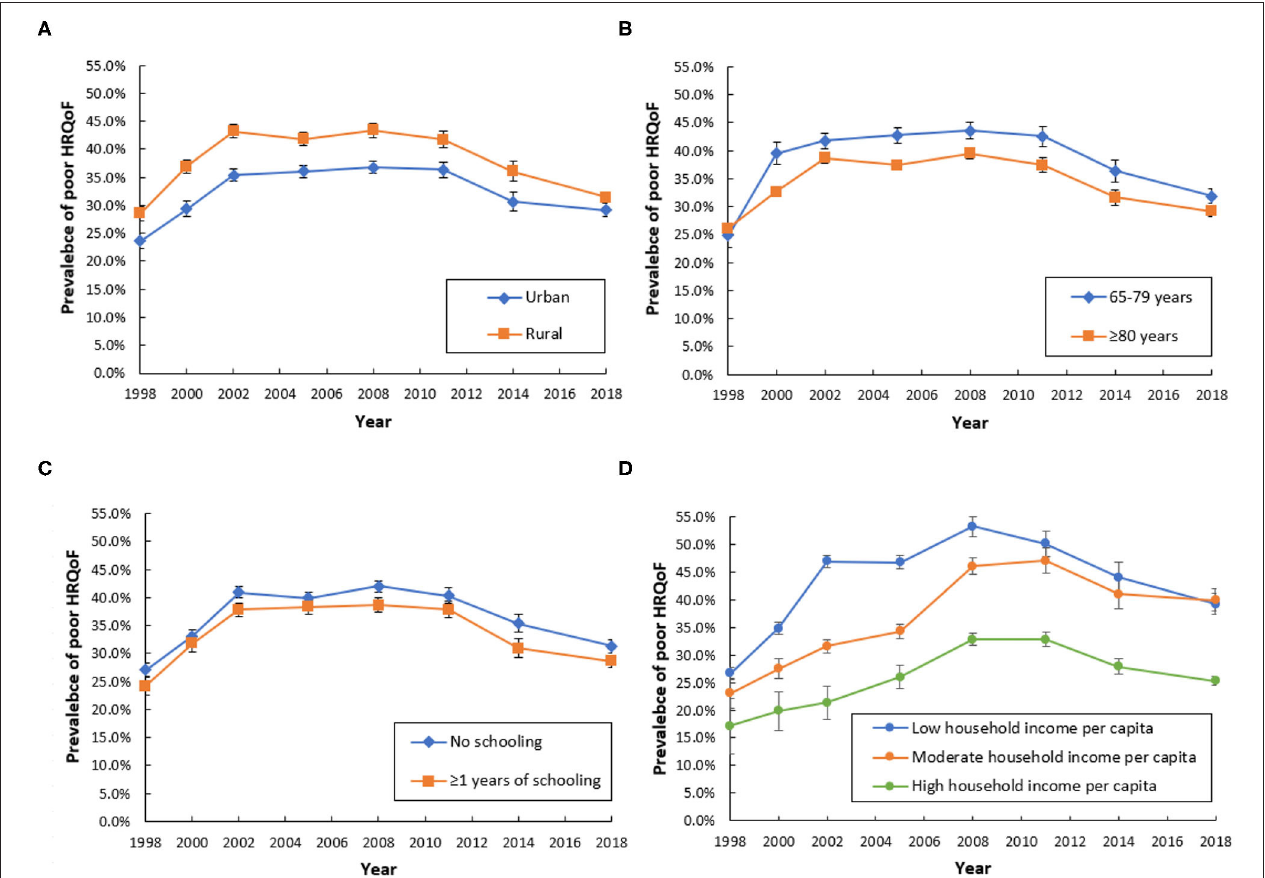
FIGURE 3 | Trends of poor quality of life from 1998 to 2018 by region (A) , age (B) , education (C) , and household income per capita (D)